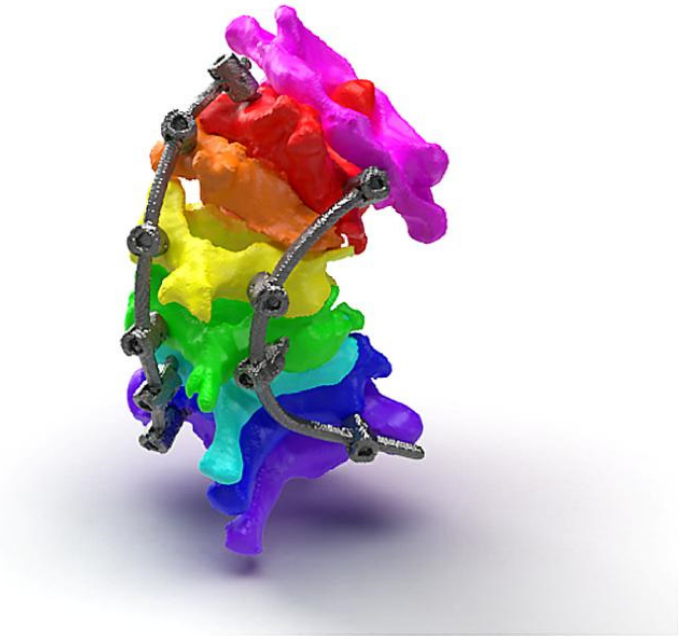
Figure 5. The PLA-VIR reconstructed starting from computed-tomography DICOM files of the Figure 5. The PLA ‐ VIR reconstructed starting from computed ‐ tomography DICOM files of the PLA-3DP model as in Figure 4B. Each vertebra is marked with a different PLA ‐ 3DP model as in Figure 4B. Each vertebra is marked with a different color.